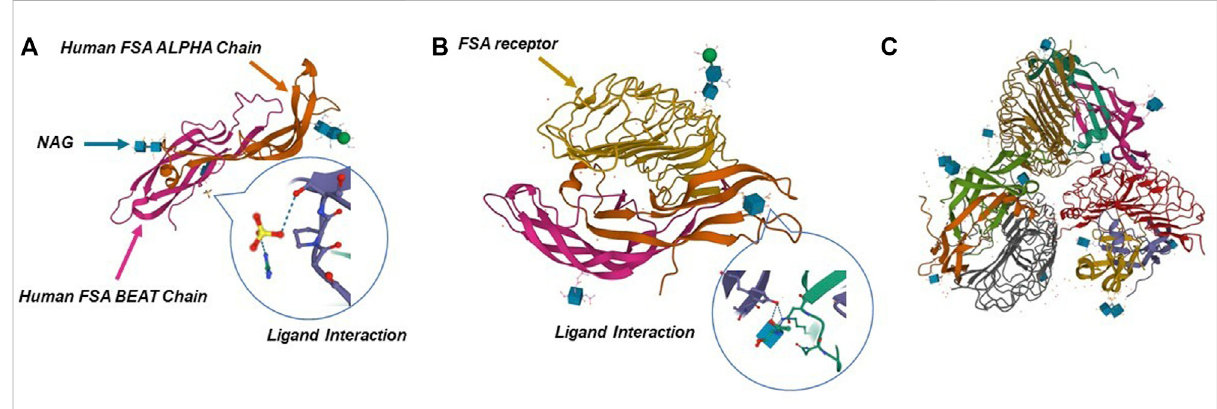
FIGURE 2 Crystal structure of human FSH complexed with its receptor. (A) 3D structure of human FSH. (B,C) Structure of FSH in complex with the entire ectodomain of FSHR. Pictures refer to Protein Data Bank database (1FL7, 1XWD, and